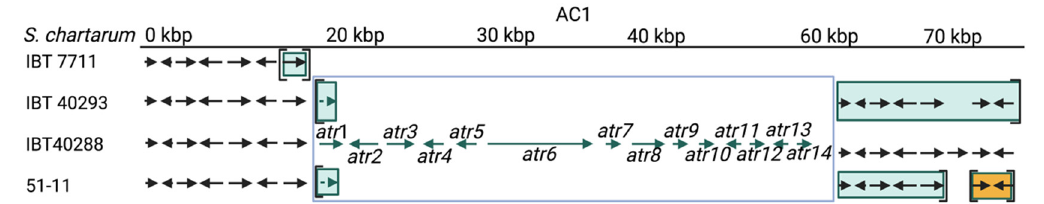
Figure 5. The atranone cluster 1 (AC1) region annotated for four S. chartarum strains. Arrows indicate genes. The boxed genes represent the AC1. Genes in square brackets are not part of the scaffold harboring AC1 and/or its upstream region but reside instead in other scaffolds. (IBT 7711: upstream = scaffolds 1183 and (1150)), IBT 40293: upstream = scaffold 1452; downstream = (scaffold 1474)), IBT 40288: scaffold 1 and 51-11: upstream = scaffold 47; downstream are five genes of scaffold (127) and two genes of scaffold (11)). An identical coloration indicates affiliation to a common scaffold in the respective strain.